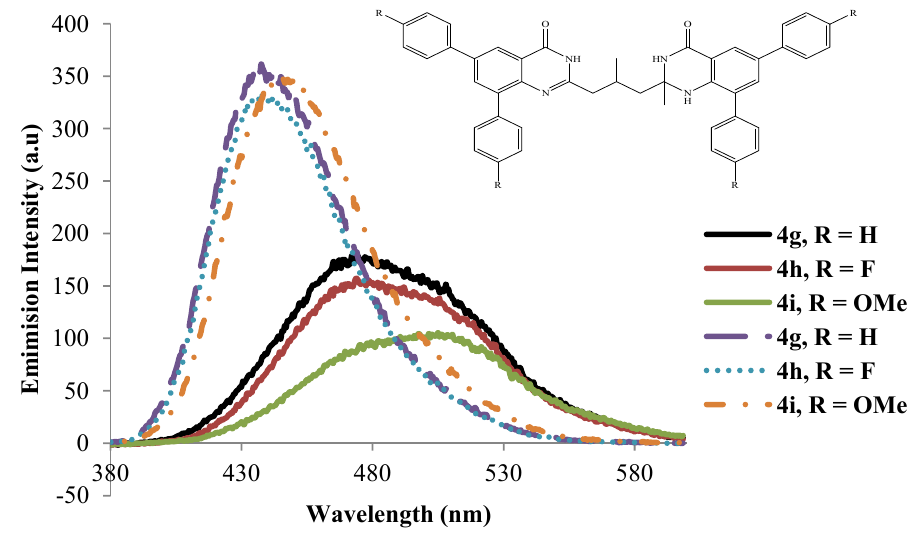
= 270 nm) in DMSO (dashed lines) and CH ex